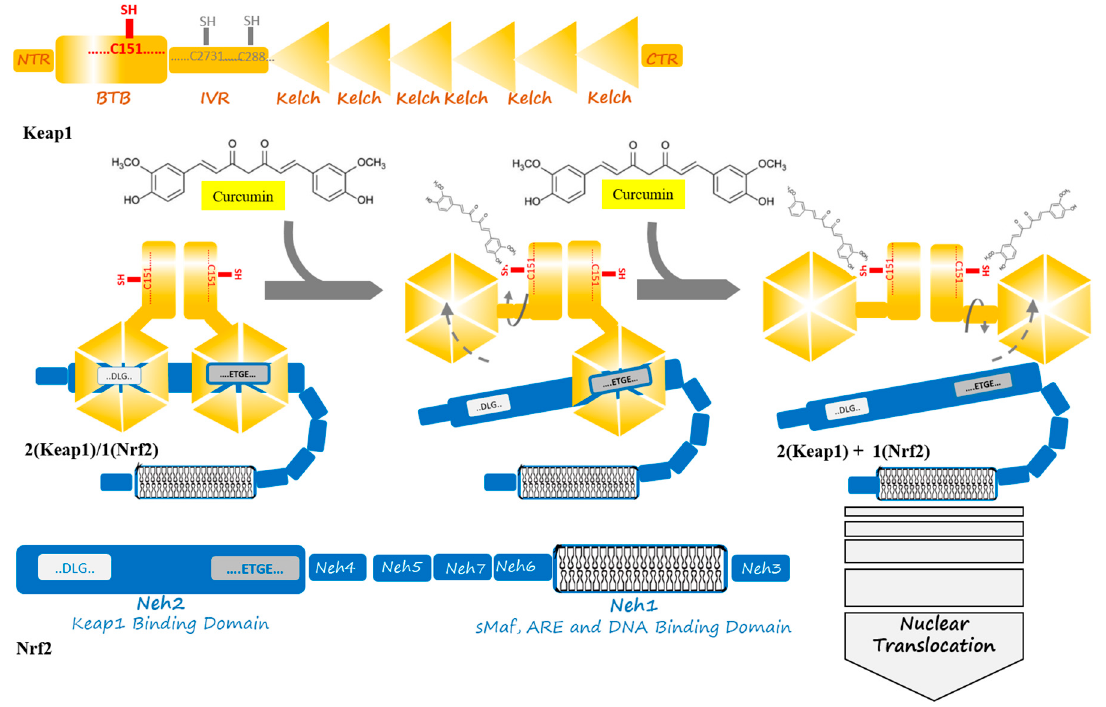
Figure 2. Curcumin induces a change in Keap1 conformation through binding to the sensor C151 residue of the Keap1 at the BTB domain. This binding is supposed to result in successive breaking of low- and high-affinity interactions between the Kelch domain of Keap1 and DLG- and ETGE motifs from Nrf2. The released Nrf2 is able to translocate to the cell nucleus to act as a transcription factor where starts anti-oxidant enzymes expression in an ARE and sMaf collaboration.